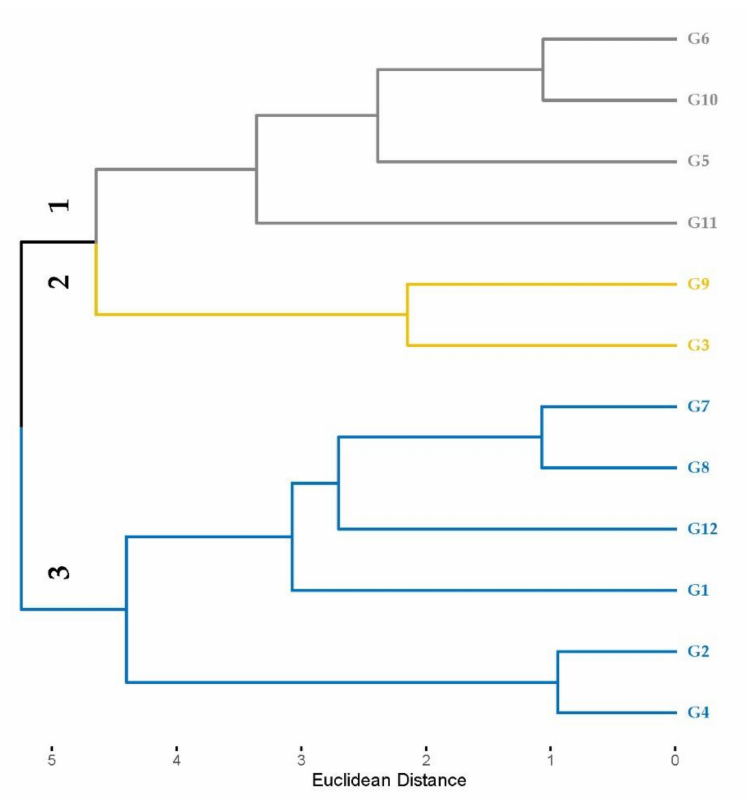
Figure 8. Dendrogram generated by the HCA of dissimilarities among the chickpea accessions on their Euclidean distances for the seed quality parameters, such as fat, ashes, starch, protein content, and protein yield. Each joining (fusion) of three clusters is represented on the graph by the splitting of a horizontal line into two horizontal lines. The horizontal position of the split, as indicated by the short vertical bar, gives the distance (dissimilarity) between two clusters. Three major accessions groups were identified by this analysis and their numbers have been presented above the differentiating node.